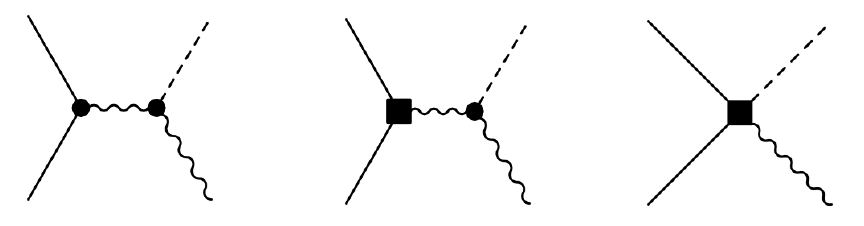
Figure 3 . Leading-order contribution to the associated production of a Higgs and a vector boson. Dots denote SM vertices, while squares denote an insertion of (cid:24)